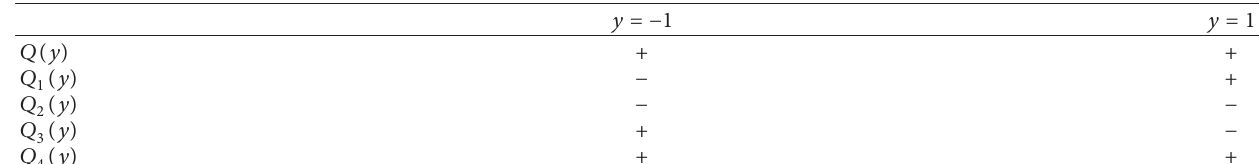
Table 2: Change the signs of Strum sequence for Q .